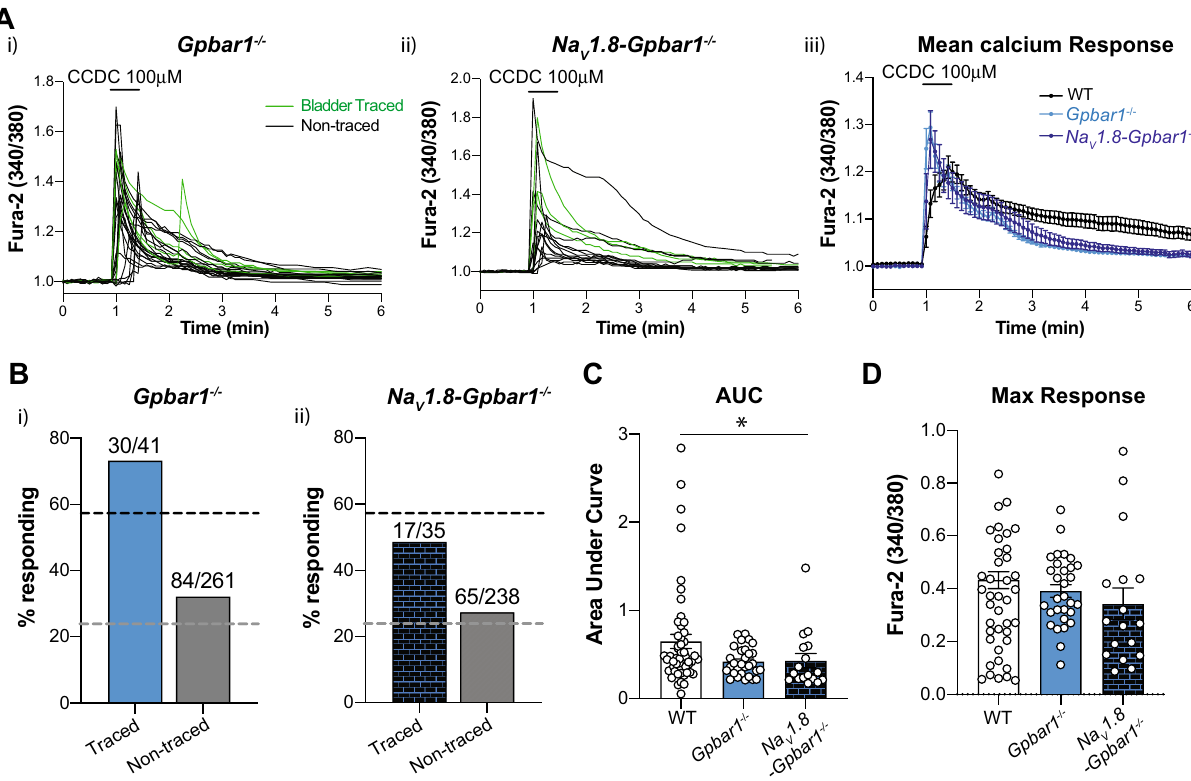
Figure 8. Intracellular calcium responses to CCDC in neuronal cultures from Gpbar1 −/− and Na V 1.8‑Gpbar1 −/− mice. ( A ) Intracellular calcium changes were measured in bladder-traced (green) and untraced (black) lumbosacral dorsal root ganglia (LS DRG) neurons from Gpbar1 −/− and Na V 1.8 - Gpbar1 −/− mice in response to CCDC (100 µM). Example experiments from ( i ) Gpbar1 −/− and ( ii ) Na V 1.8 - Gpbar1 −/− mice showing bladder traced (green) and non-traced (black) neurons from a single coverslip responding to CCDC (100 μM). Each line represents a single neuron and an increase in the Fura-2 fluorescence ratio (340/380) indicates an increase in intracellular Ca 2+ . ( iii ) Mean ± SEM of intracellular Ca 2+ responses to CCDC (100 μM) in bladder-innervating neurons from Wildtype, Gpbar1 −/− and Na V 1.8‑Gpbar1 −/− mice. ( B ) The percentage (%) of neurons responding to 100 µM CCDC in Gpbar1 −/− and Na V 1.8 - Gpbar1 −/− mice. ( i ) 73.2% (30 out of 41) of bladder-traced Gpbar1 −/− neurons, and ( ii ) 48.6% (17 out of 35) of bladder-traced Na V 1.8 - Gpbar1 −/− neurons responded to CCDC. Dashed black and grey lines represent % of bladder-innervating neurons and untraced neurons from wildtype mice responding to CCDC (100 µM). ( C ) The average intracellular calcium change over time (AUC) in response to 100 µM CCDC was determined for Gpbar1 −/− (light blue) and Na V 1.8 - Gpbar1 −/− (dark blue) bladder-traced LS DRG neurons and compared to wildtype (white). No statistical difference in the area under the curve (AUC) was observed between wildtype and Gpbar1 −/− responses (ns, P > 0.05), whereas Na V 1.8 - Gpbar1 −/− bladder- traced responses had a significantly reduced AUC compared to wildtype (* P < 0.05). No significant difference was observed in the AUC between Gpbar1 −/− and Na V 1.8 - Gpbar1 −/− responses. ( D ) Maximum fluorescent responses to CCDC (100 µM) were not significantly different between wildtype, Gpbar1 −/− and Na V 1.8 - Gpbar1 −/− bladder-traced neurons (ns, P > 0.05). Data are represented as percentage of cells ( B ) or mean ± SEM ( C , D ) with individual data points in ( C , D ) representing values from individual cells. P values above were determined by Kruskal–Wallis non-parametric analysis of variance with Dunn’s multiple comparisons tests ( C , D